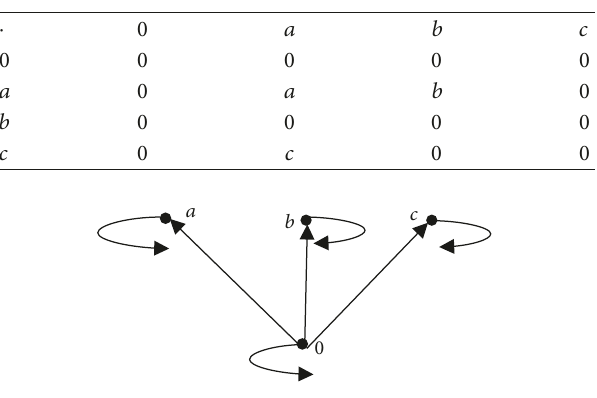
Table 2: Multiplication table of ordered semigroup 𝑆 .